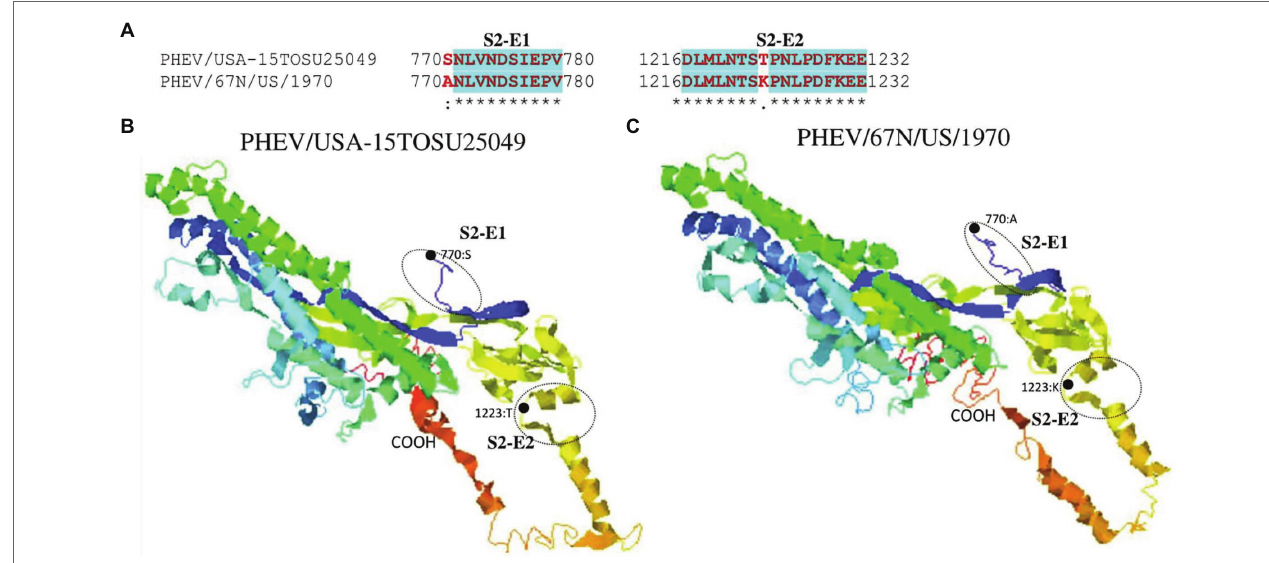
FIGURE 6 | Comparison of linear B cell epitopes affected by amino acid variations in the S2 domain between PHEV/USA-15TOSU25049 and PHEV/67 N/ US/1970. (A) Amino acids of the predicted linear B cell epitope are indicated with bold red letters, while numbers refer to their positions relative to the full-length S glycoprotein. Three-dimensional view of epitopes in the S2 domain of PHEV/USA-15TOSU25049 (B) and PHEV/67 N/US/1970 (C) . The predicted epitopes are circled, and the amino acid variations are marked with black